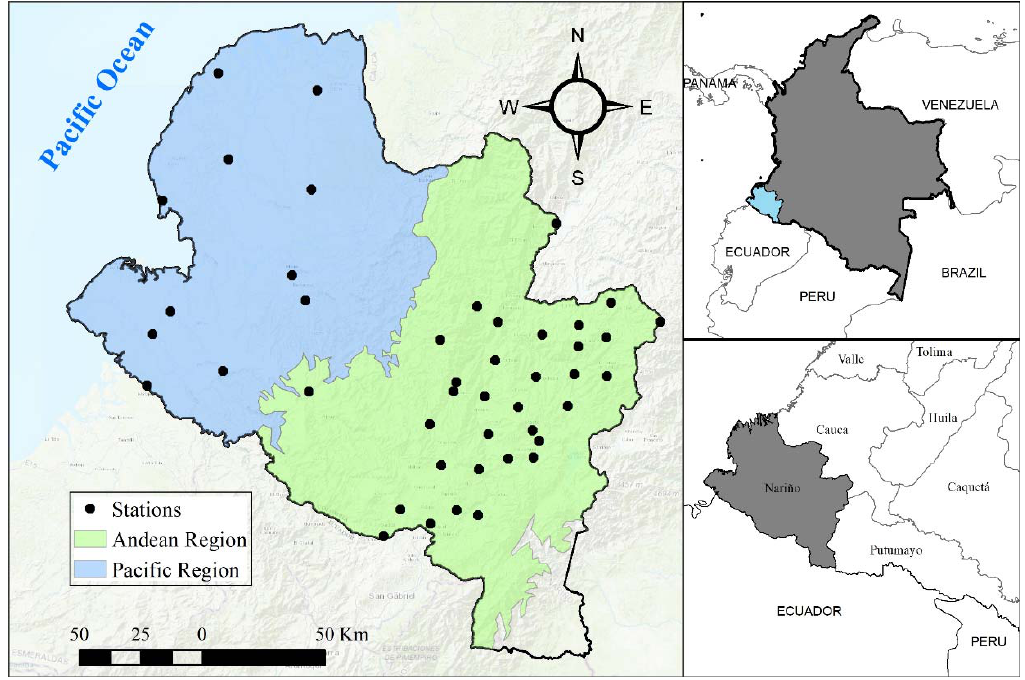
Figure 1. Geographic location of the study area and distribution of rainfall gauge stations .